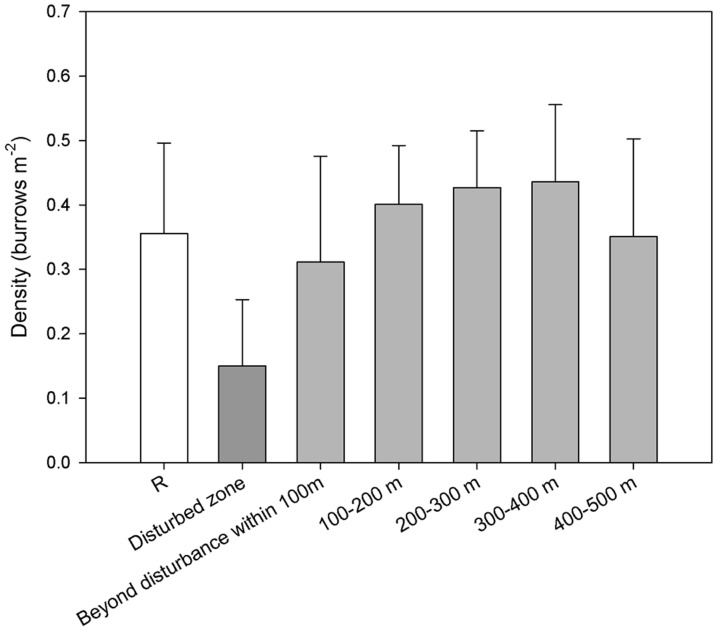
Mean density of decapod burrows (±sd) in the Post 3 survey at Morvin.White = Background, dark grey = Visible Disturbance, light grey = Beyond Disturbance.